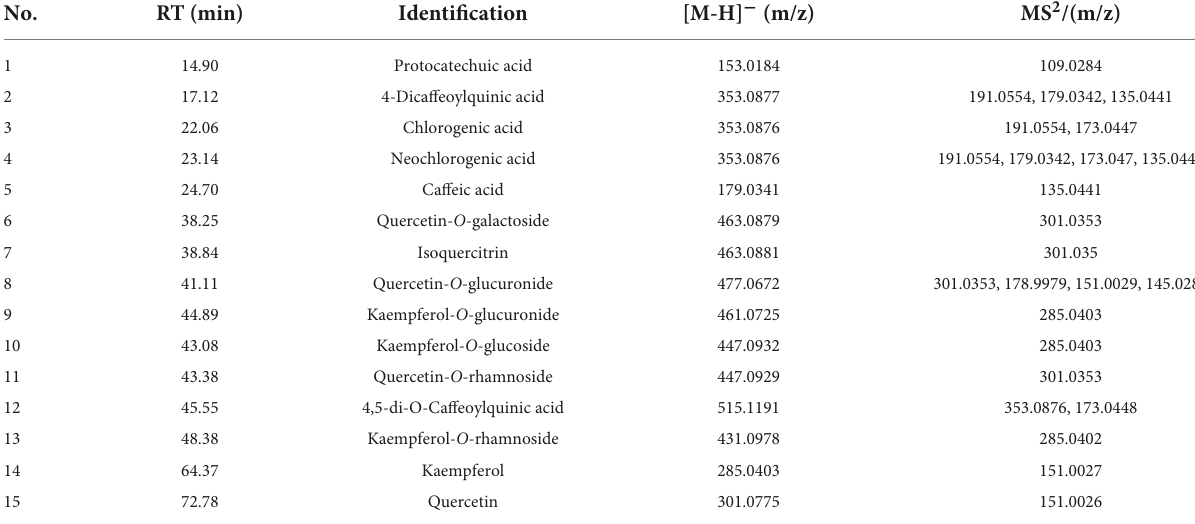
TABLE 1 The identified phenolics compounds of aqueous extracts of Cyclocarya paliurus leaves based on the UHPLC-ESI-MS/MS analysis.